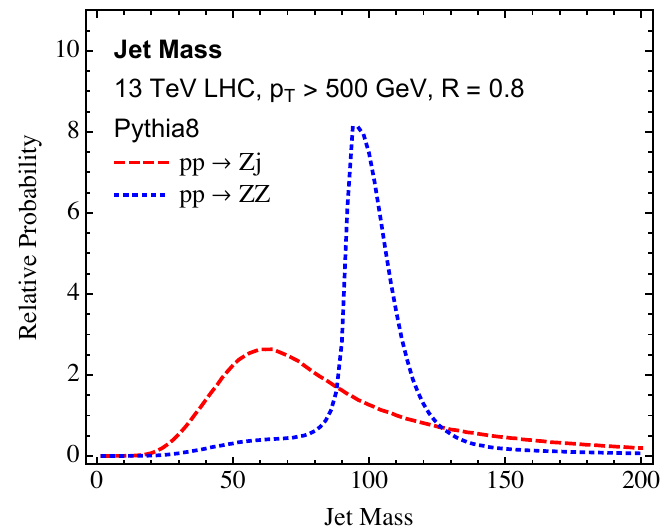
Figure 3. Distribution of the mass of the jet in pp Zj (red dashed) and hadronically-decaying ! Z boson in pp ZZ (blue dotted) from the Pythia parton shower. The minimum transverse ! momentum is 500 GeV, and the jets are found with the anti- k T algorithm with radius R = 0 : 8. we plot the mass of the signal and background jets as de(cid:12)ned by the simulation and